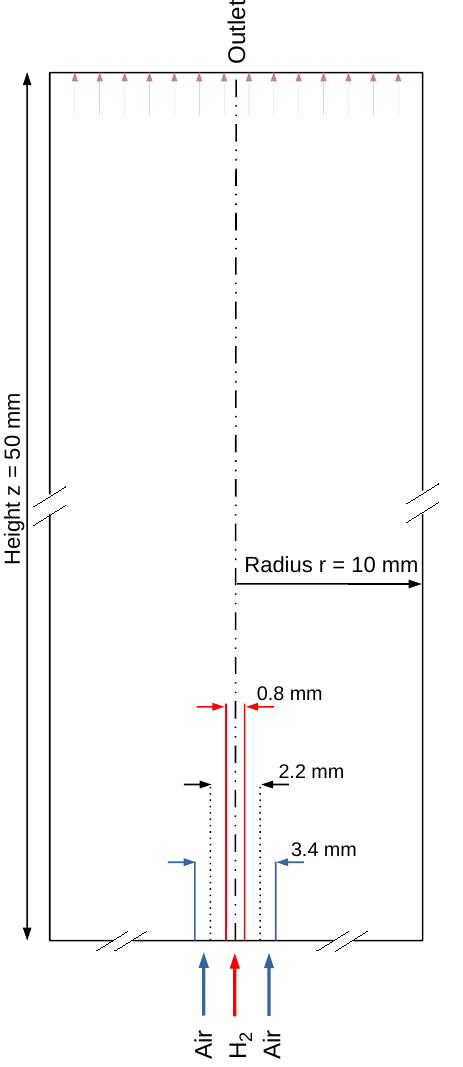
Figure 1. 2-dimensional cross section of the selected 3-dimensional geometry of the simulated